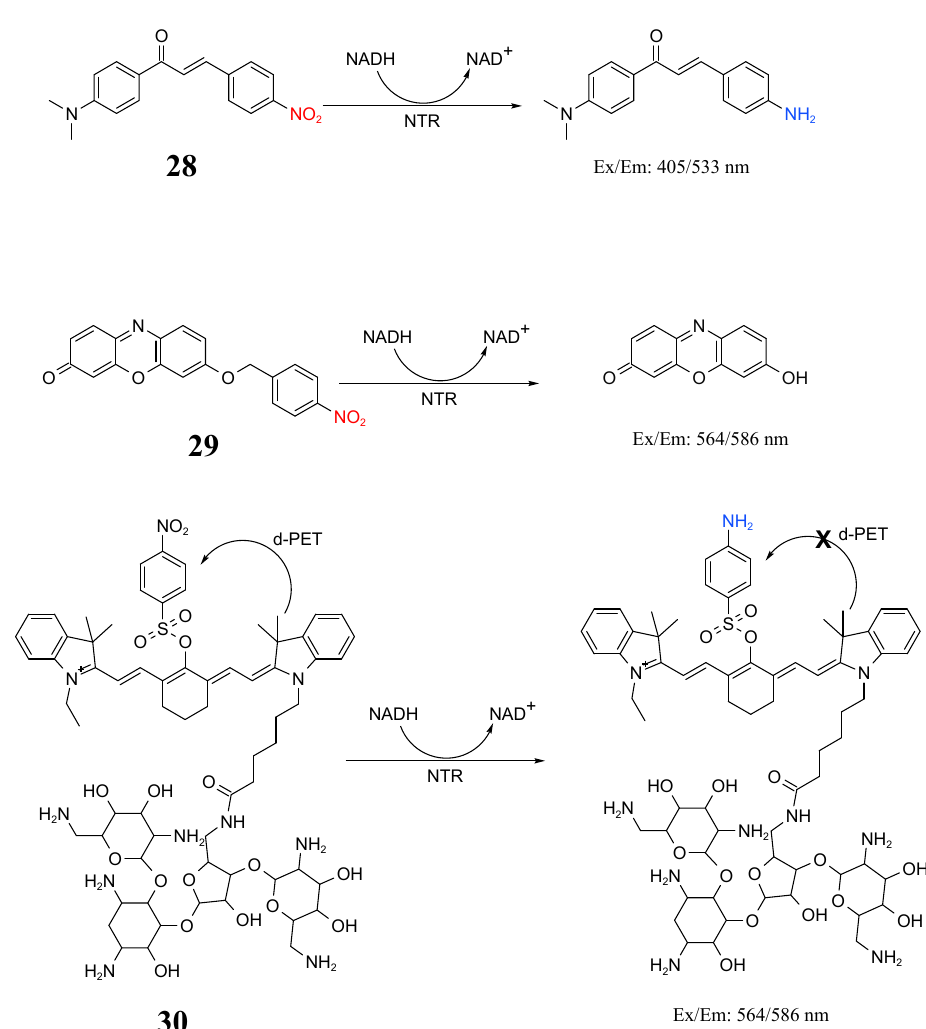
Figure 16. Structure and identification mechanisms of probes 28 – 30